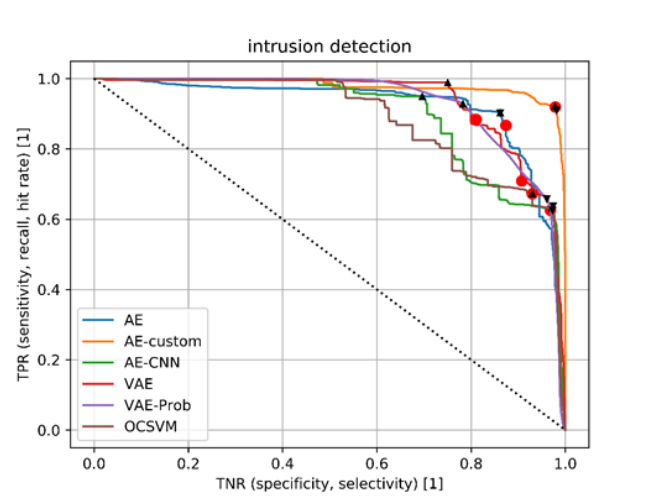
Figure 4. ROC curves for the tested algorithms on the independent test dataset.